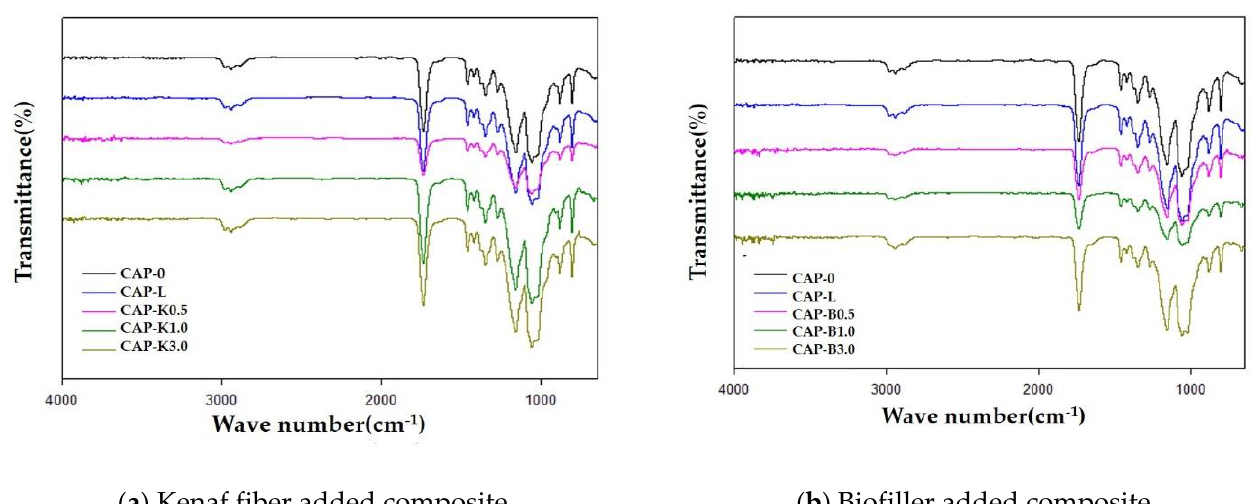
Figure 15. FT-IR spectra of plasticized cellulose acetate propionate–biofiller composites.